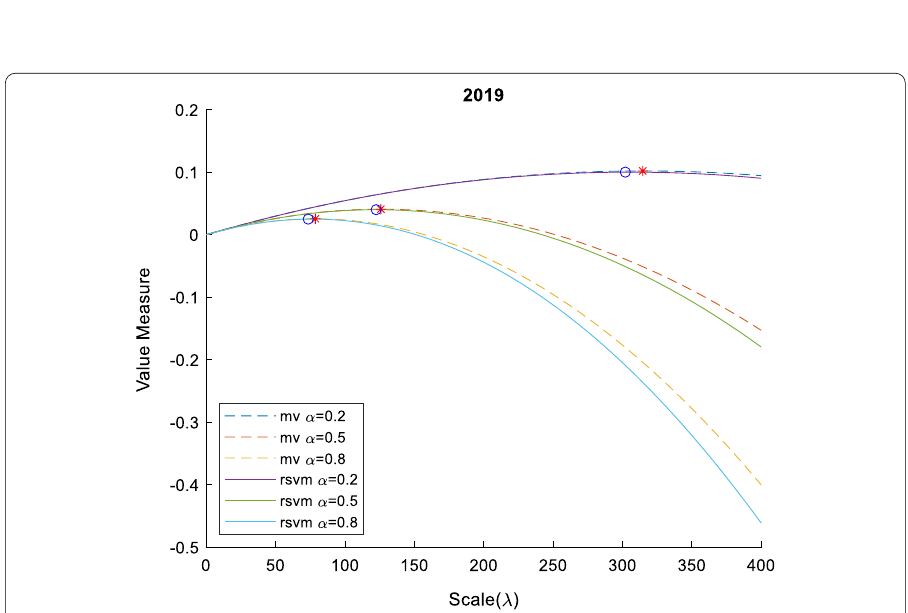
Fig. 6 Value measure of RSVM and MV with various risk aversion α and scale (cid:31) in 2019. This figure shows the relation between value measure (mean–variance model with dash line and risk‑sensitive value measure with line) and scale with different investors (risk‑averter α = 0.8 , risk‑neutral α = 0.5 , and risk‑seeker α = 0.2 ) in 2019. The red star and blue circle are optimal scale of mean–variance model and risk‑sensitive value measure,